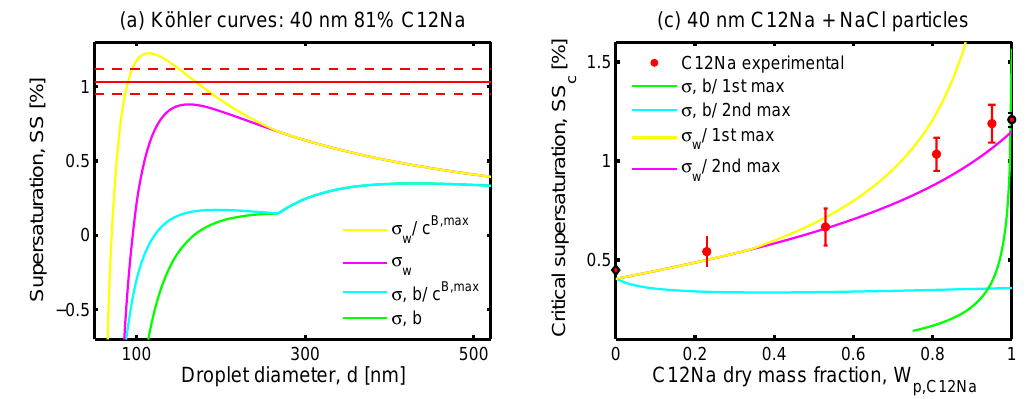
Fig. B2. Model predictions with surfactant representations σ,b and σ w , for dry sodium dodecanoate (C12Na) and NaCl particles of diameter D p = 40nm, testing the sensitivity to limited C12Na concentration in the droplet bulk-phase ( c B particles comprising 81% by mass of C12Na, and (b) critical supersaturations ( SS c [ % ] ), given by the predicted K¨ohler curve maxima, as functions of dry particle C12Na mass-fraction ( W p, C12Na ). In panel (a), the experimental critical supersaturation with corresponding 95%-confidence interval is depicted with the solid and stipulated red lines, respectively. See Sect. B5 for